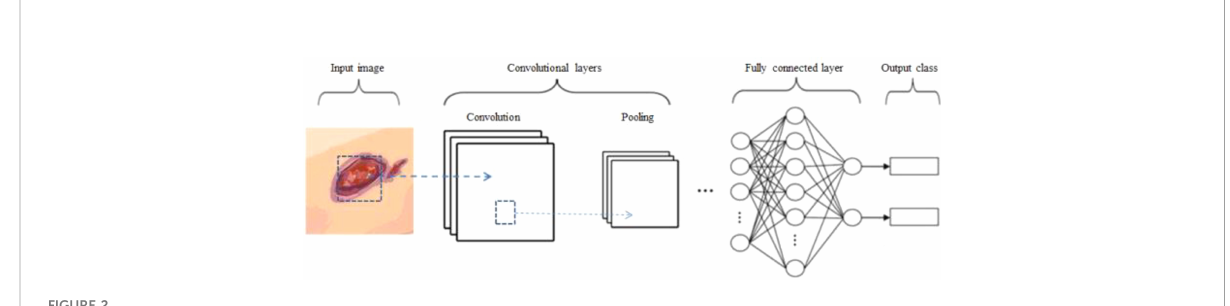
FIGURE 2 Architecture of a convolutional neural network (CNN) for image classi fi cation. Images of the DFU are inputted into the CNN model, which included convolution, pooling, dropout, and fully connected (FC) layers. After these images are processed by the model, they are fi nally classi fi